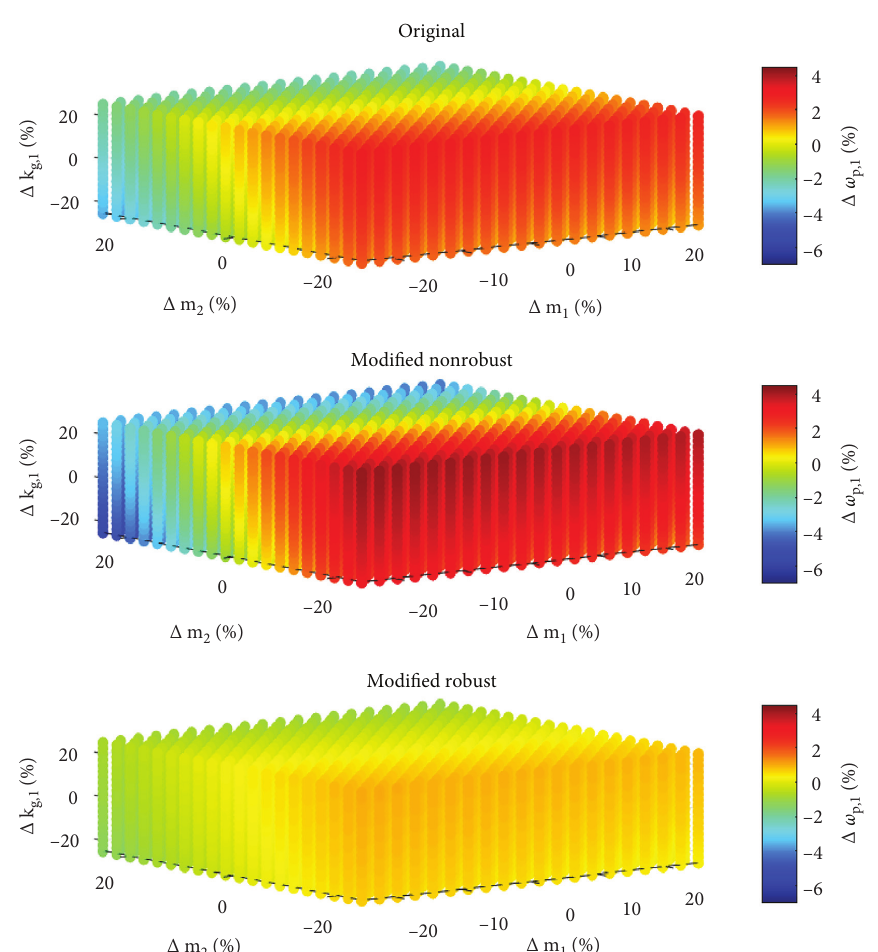
Figure 3: Test-case 1: percentage variation of the first natural frequency in the original and modified systems without and with robustness constraint. Simultaneous perturbations of m 1 , m 2 , and k g . 1 Table 5: Test-case 1: the original and modified systems without and with robustness: percentage variation of the first natural frequency. Percentual